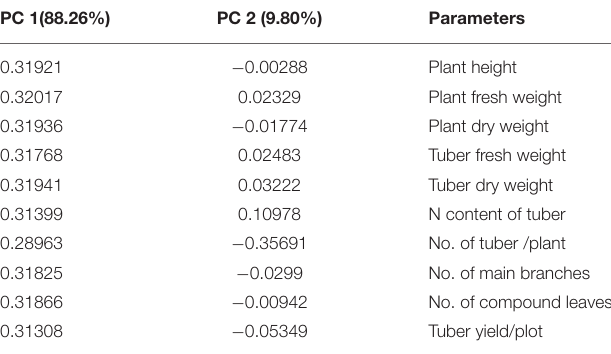
TABLE 6 | Factor loading and values of percentage variance for different agronomic parameters obtained in PCA analysis. PC 1(88.26%)